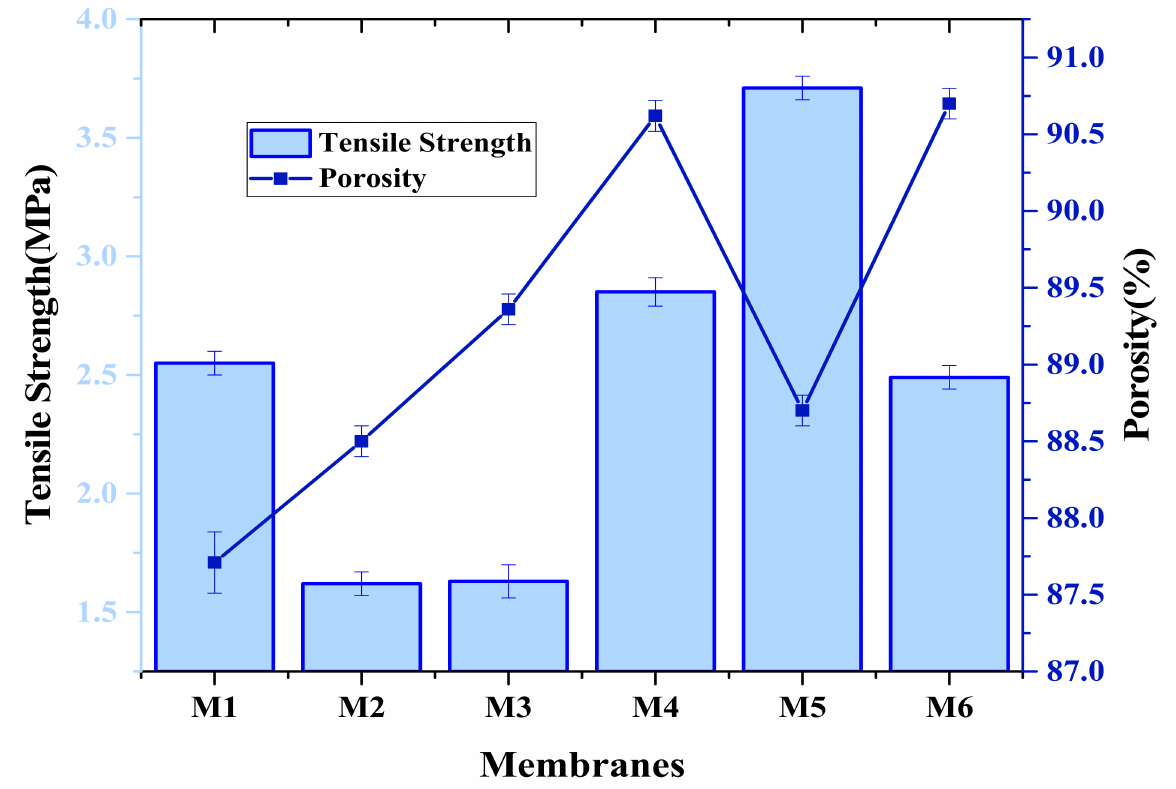
Figure 9. Mechanical properties vs. porosity of aminated graphene oxide based PVDF